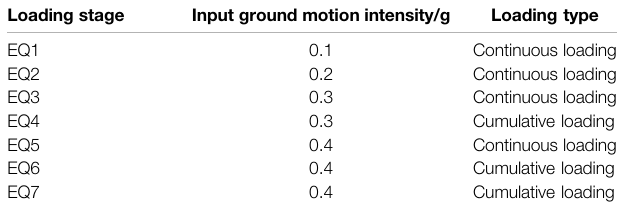
TABLE 3 | Ground motion loading